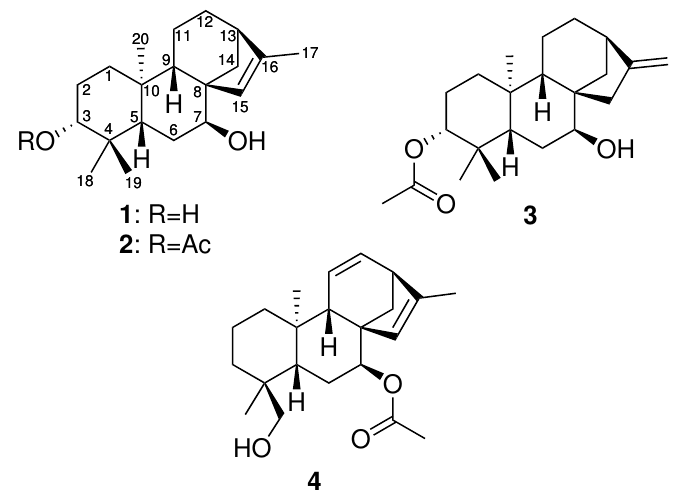
Figure 1. Structure of the new ent -kauranes compounds 1 – 4